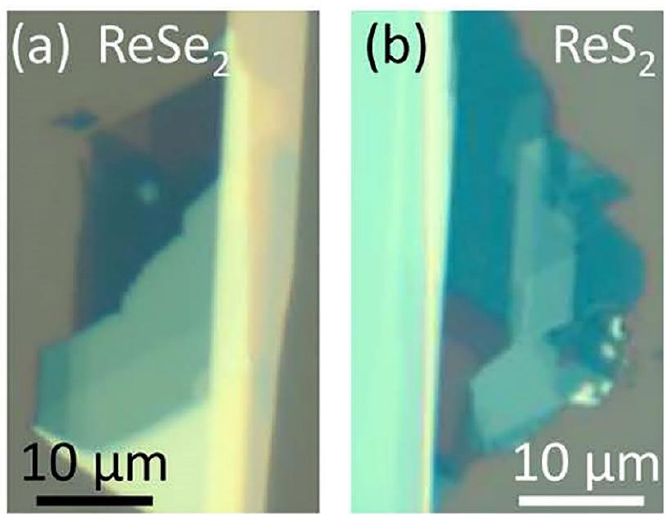
Figure 7. Optical image of a N-layer ( a ) ReSe 2 and ( b ) ReS 2 crystal. Reproduced with permission from Ref. [88]. Copyright 2016, American Chemical Society.